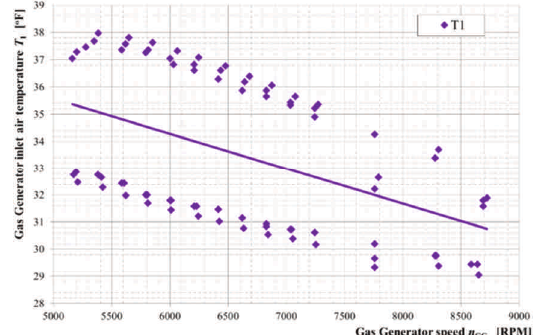
Fig. 8. Approximated function and the results of the measurements of gas generator inlet air temperature T 1 , recorded for steady-state operation of